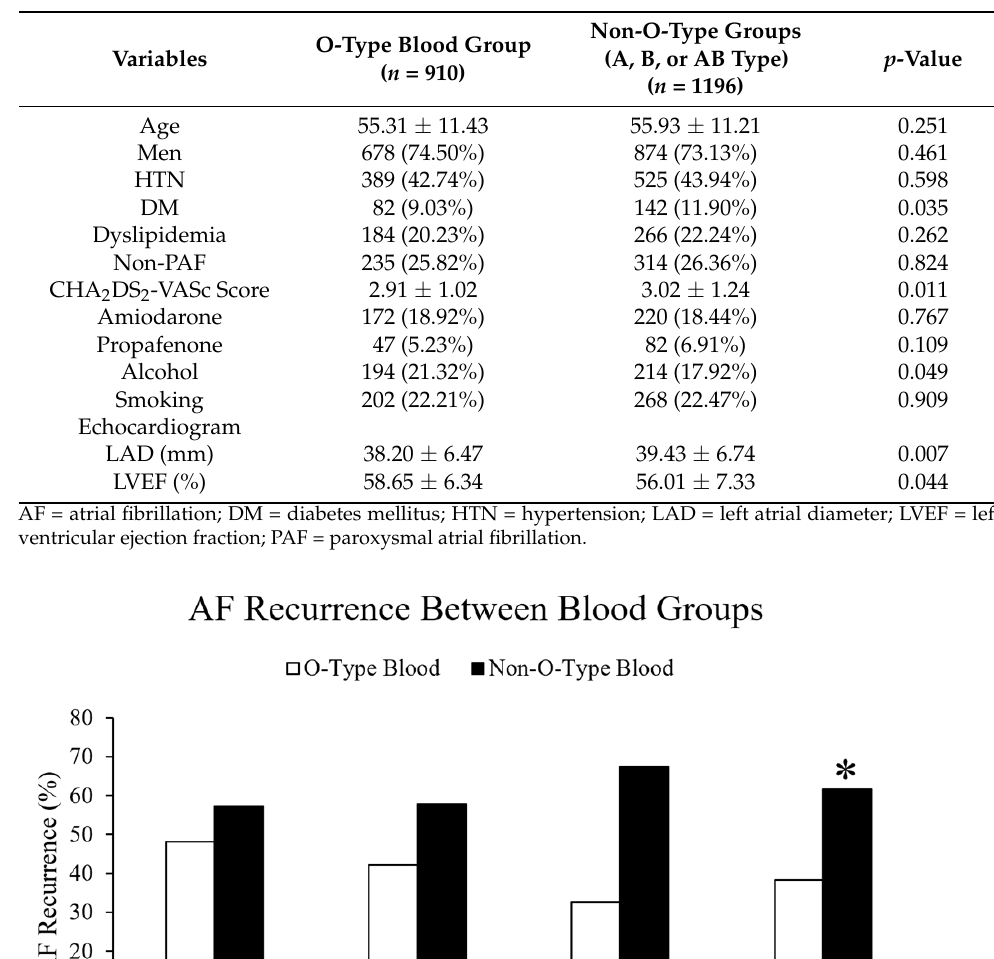
(Table 2). Compared to those without recurrence, more patients with very late recurrence re- ceived AADs, including propafenone (32.55% vs. 2.67%) or amiodarone (66.33% vs. 12.24%). The patients with very late recurrence also had a marginally higher CHA 2 DS 2 -VASc Score than those without recurrence. The univariate and multivariate analysis revealed that the non-O blood group (odds ratio:1.40, 95% CI: 1.05–1.86) and amiodarone (odds ratio: 1.44, 95% CI: 1.08–1.93) were independent predictors for very late recurrence in the non-PAF patients after catheter ablation (Table 3). Table 1. Comparison of patient characteristics between the O-type and the non-O-type blood groups (A, B, or AB type).